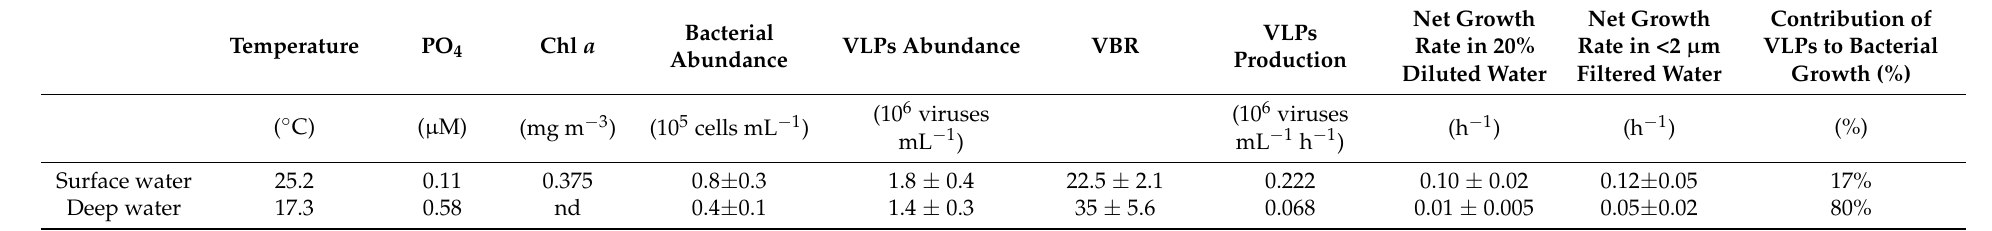
Table 1. Physical, chemical, bacterial and VLP abundance, VBR, VLP production, and contribution of VLPs to bacterial growth (%) in sunlit surface and dark, deep waters, respectively.